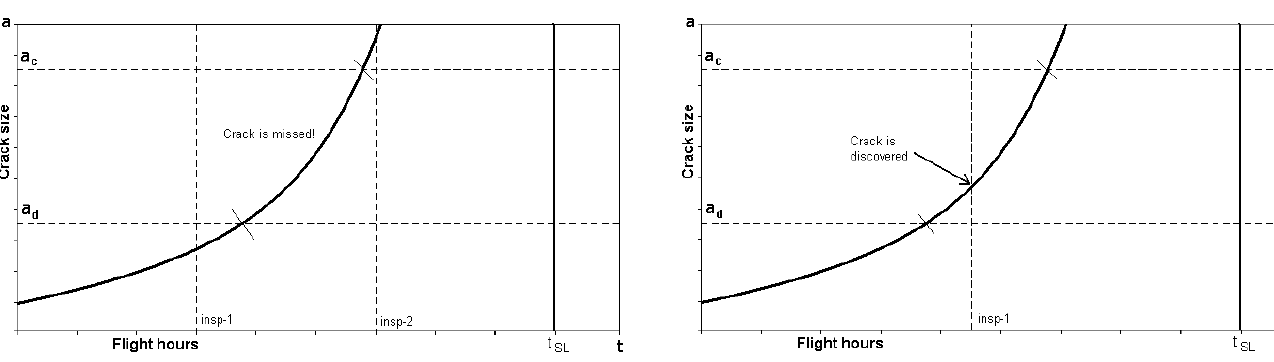
Fig 6. Demonstration of non-monotonous nature of